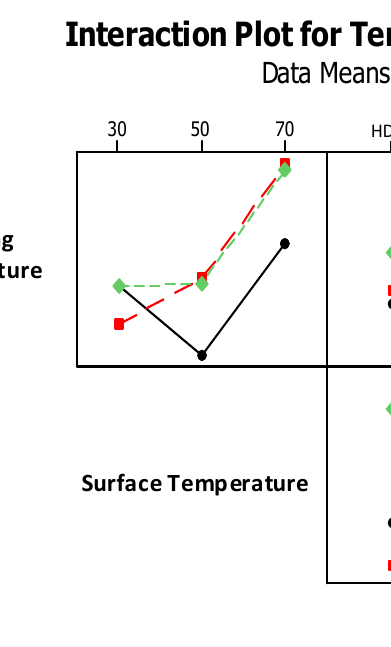
Figure 4. Mian effects plot for tensile strength.